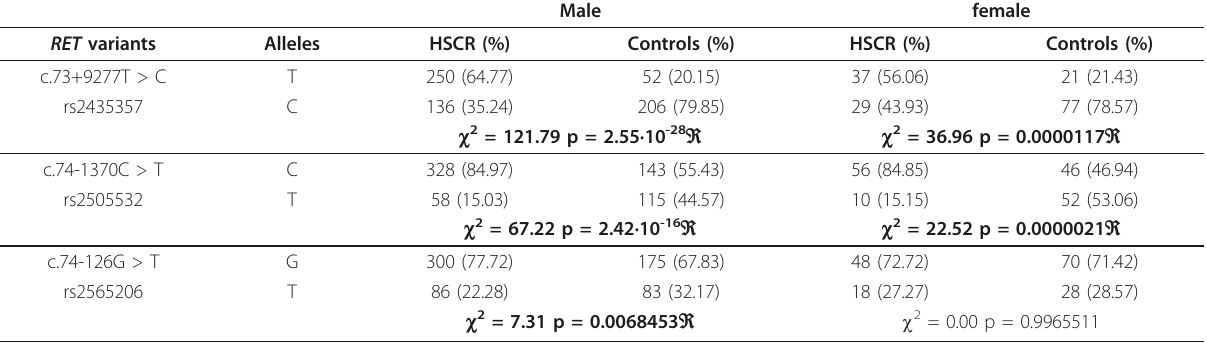
Table 2 Allelic distribution frequency of the RET SNPs